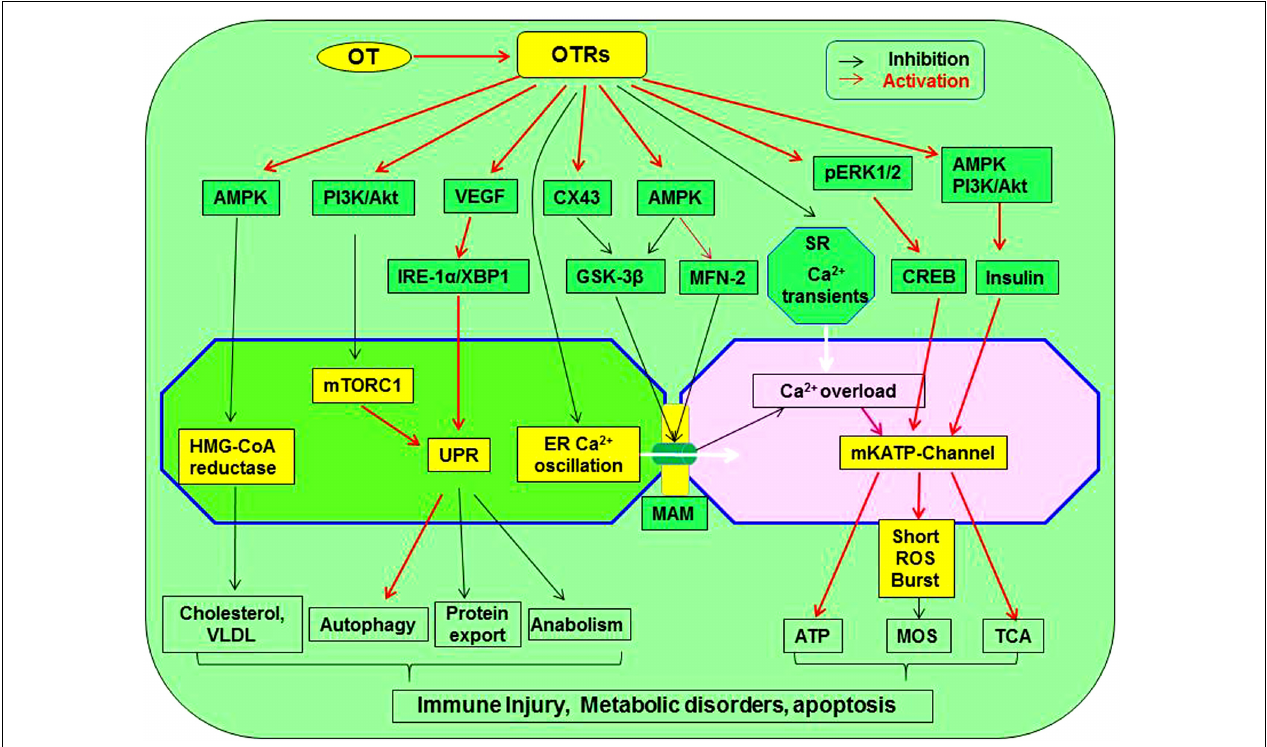
FIGURE 3 | Working model of OT suppression of the malfunctioned ER-mitochondrial communication. OTR activation can inhibit inflammation, ER stress, restore UPR and chaperone functions, reduce the production of cholesterol and VLDL, inhibit ER-mitochondrial Ca 2 + oscillation and overload through MAM, precondition MOS, restore TCA cycle, and suppress inflammatory and apoptotic pathways, leading to regeneration and repair of injured cardiomyocytes. These processes are signaling through activating AMPK, pERK1/2, PI3K/Akt, VEGF, and CX43 while inhibiting mTORC1, HMG-CoA reductase, GSK-3 β , and calcium oscillation. As a result, lipotoxicity and formation of atherosclerosis are inhibited. GSK-3 β , glycogen synthase kinase-3 β ; IRE1 α , inositol-requiring enzyme 1 α ; pERK1/2, extracellular signal-regulated protein kinase 1/2; MAM, mitochondria-associated ER membrane; ROS, reactive oxygen species; mTORC1, rapamycin complex 1; UPR, unfolded protein response; VEGF, vascular endothelial growth factor; VLDL, low-density lipoproteins; XBP1, X box-binding protein-1. Other annotations refer to Figure 2